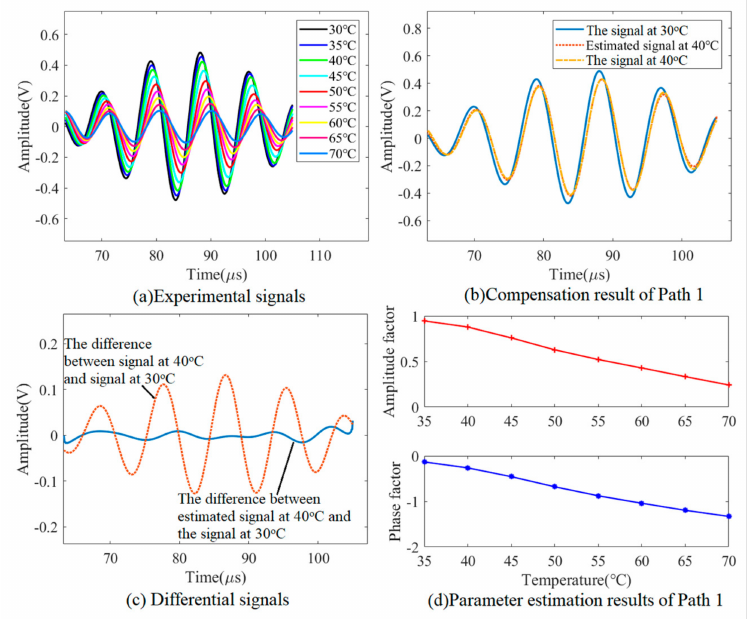
Figure 14. Experimental results of the parameter estimation